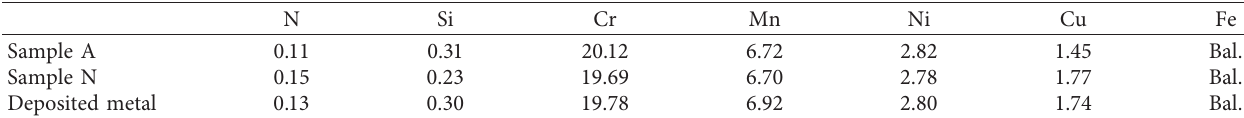
Table 4: Cross section EDS analysis results